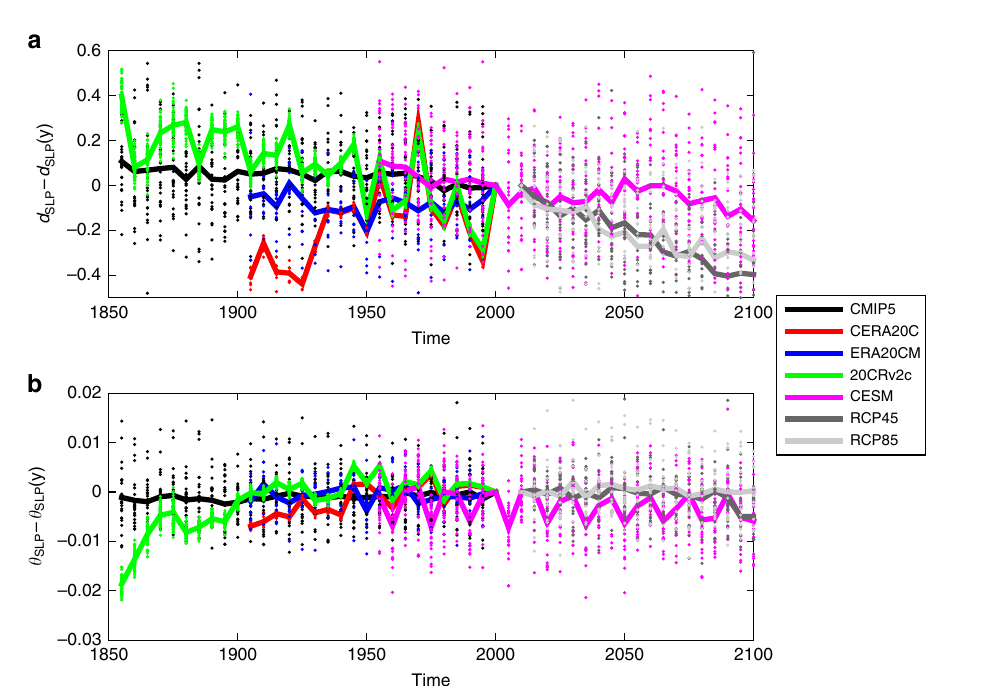
Fig. 1 Local dimension and inverse persistence for all the datasets. Five-year averages of local dimension d SLP ( a ) and inverse persistence θ SLP ( b ) minus the respective values d SLP ( y ) and θ SLP ( y ) computed for the years y = 2000 (or y = 2006 for representative concentration pathway (RCP) scenarios). Different colours correspond to different datasets as shown in the legend. Dots: single members or models. Solid lines: means of the ensembles. SLP, sea-level pressure